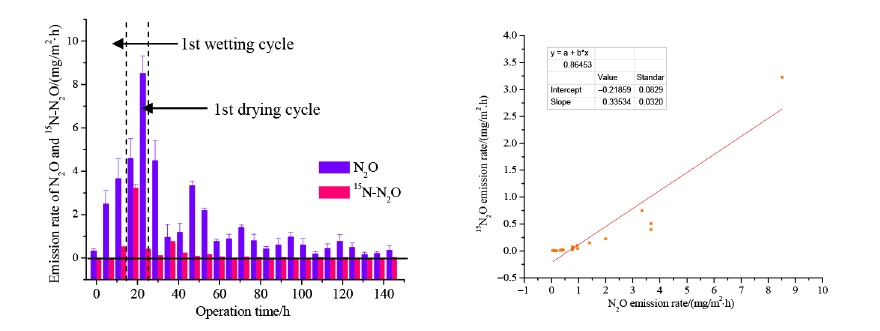
Figure 3. (a) N 2 O and 15 N-N 2 O release rate over time and (b) Linear correlation between N 2 O and 15 N-N 2 O